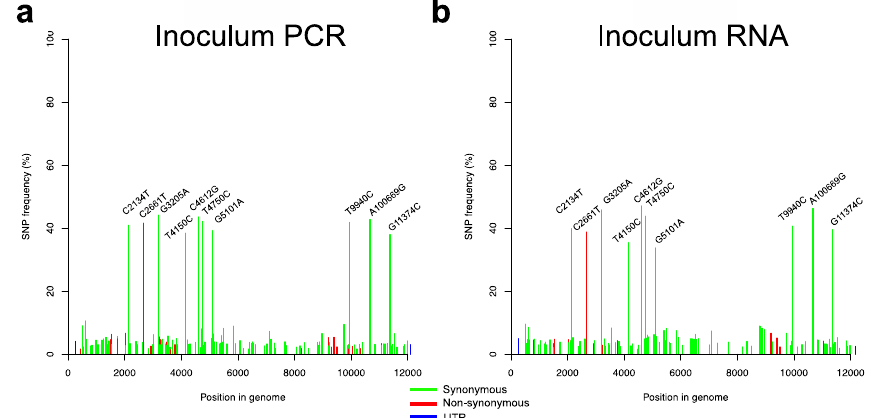
Figure 2. Single nucleotide polymorphism (SNP) frequency plots of the challenge virus in the inoculum. SNPs with a frequency above 20% are indicated for each sample type as follows: ( a ) Virus inoculum (determined following RT-PCR), and ( b ) virus inoculum (determined directly from the RNA). The red, green and blue colours of the bars represent non-synonymous, synonymous and untranslated region (UTR) mutations, respectively.